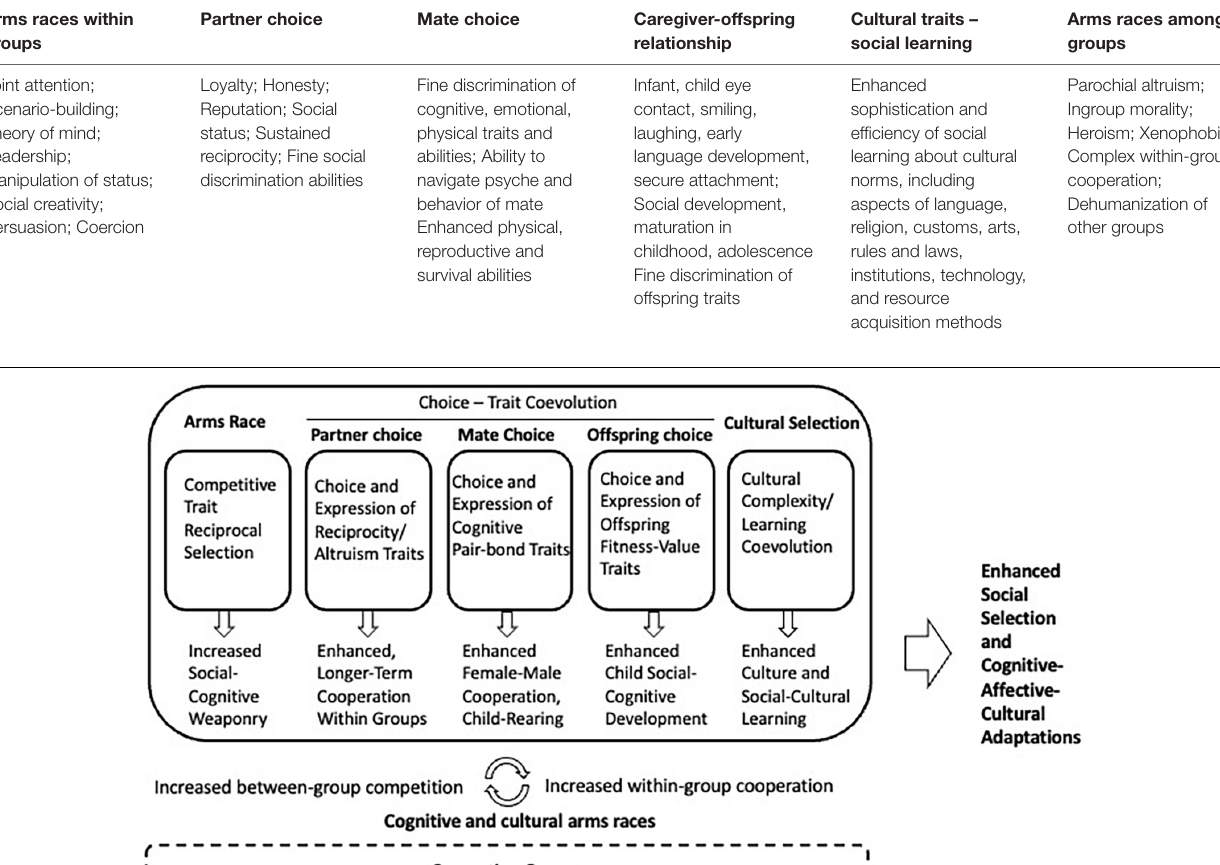
TABLE 1 | Phenotypes and abilities postulated to be selected for, in six different arenas of human social selection and evolution. Arms races within Partner choice Mate choice Caregiver-offspring groups